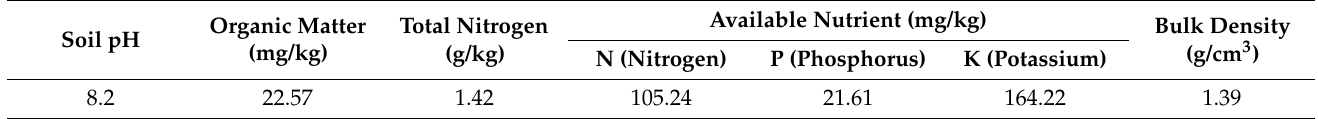
Table 1. Indicators of experimental